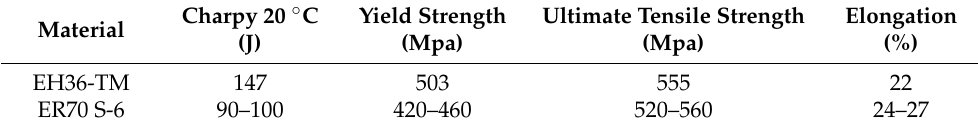
Table 3. Mechanical properties of base metal and filler